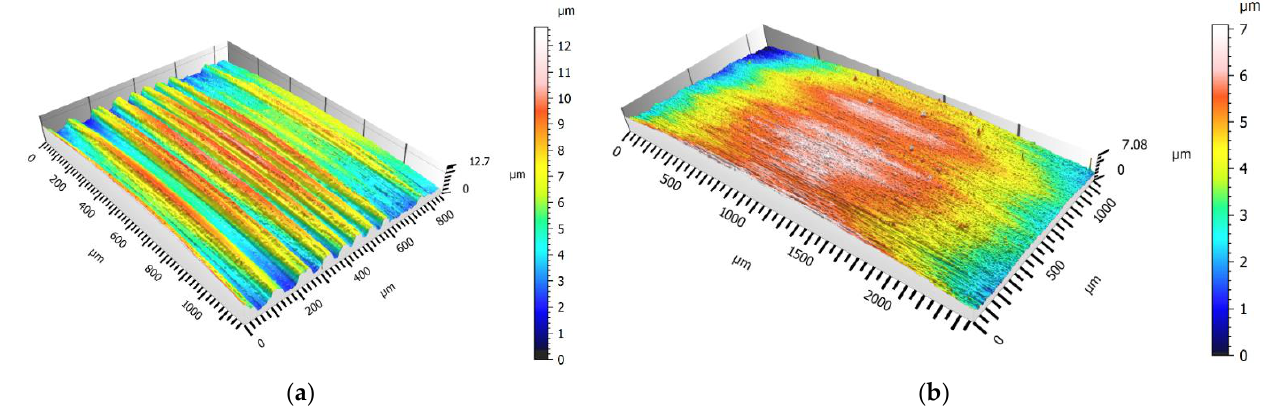
Figure 5. View of the surface topography: ( a ) UNJ thread, passive flank, v c = 30 m/min; ( b ) BUT- TRESS, active flank, v c = 30 m/min.